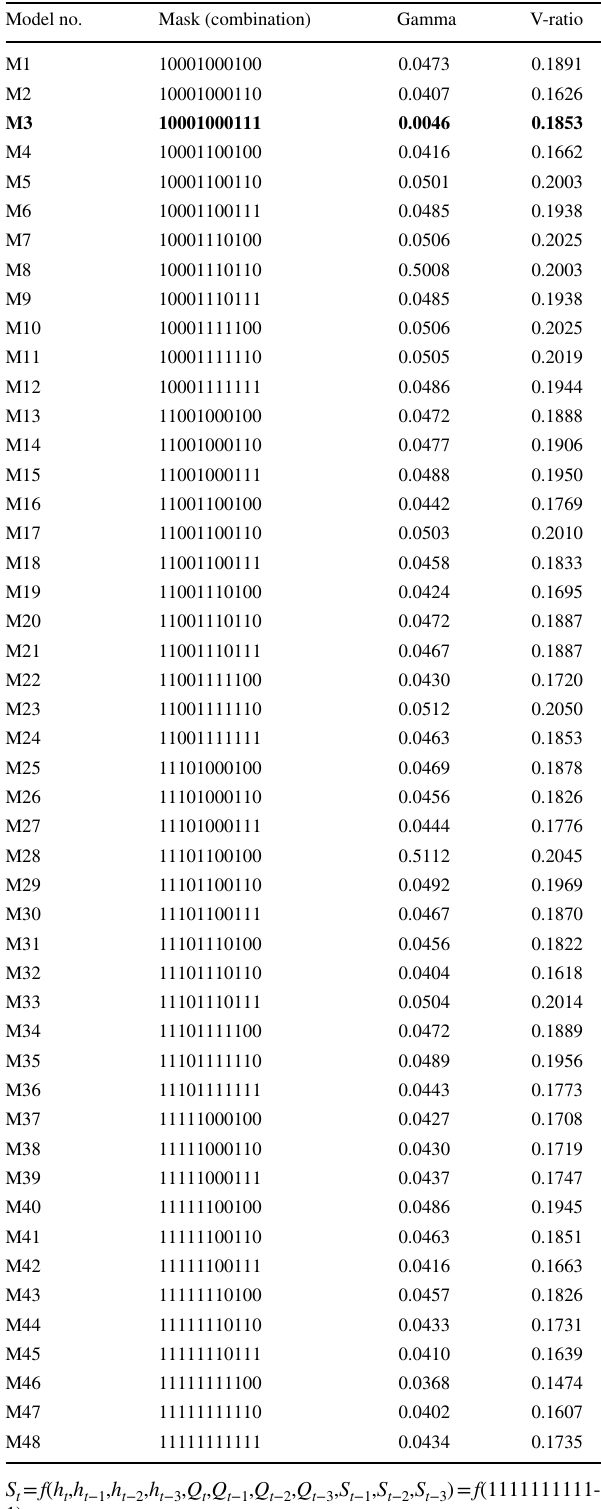
Table 4 Findings of the gamma test obtained for different combina- tions of input variables for the Ghatshila site Model